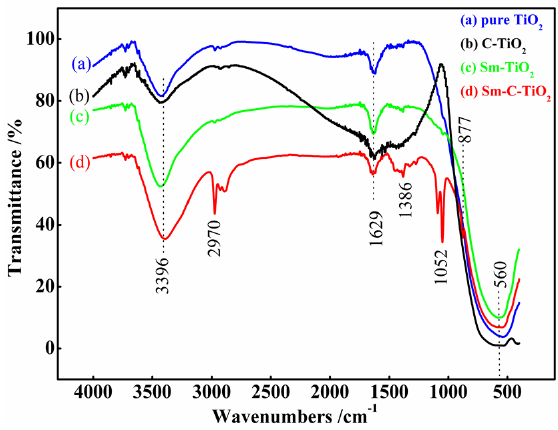
Figure 2. FT ‐ IR spectra of Sm ‐ C ‐ TiO 2 , C ‐ TiO 2 , Sm ‐ TiO 2 , and TiO 2 samples.